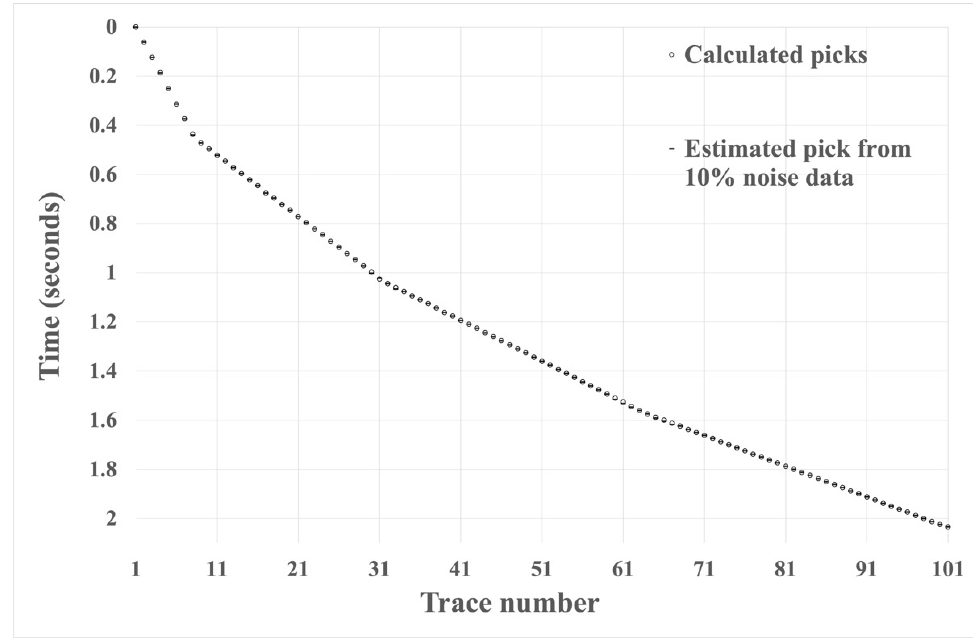
Figure 7. First arrival picks determined by the HEEH method and calculated from the model on synthetic data with 10% noise.